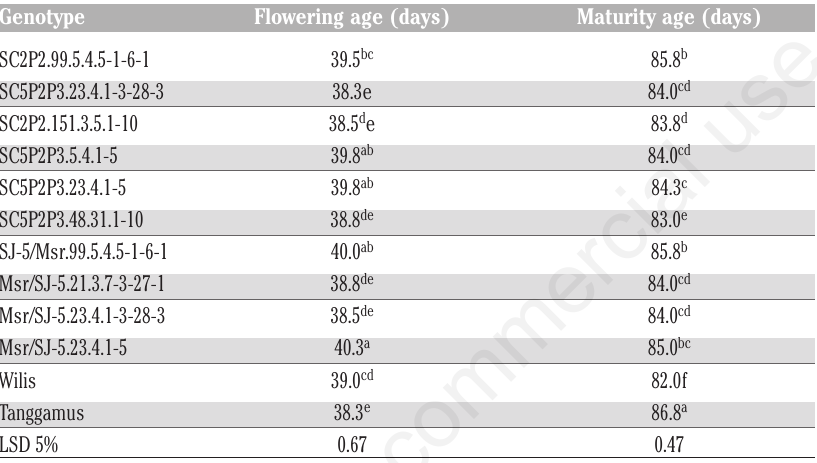
Table 4. Flowering age and maturity age of acid-adaptive soybean promising lines in Central Lampung, Indonesia. Genotype